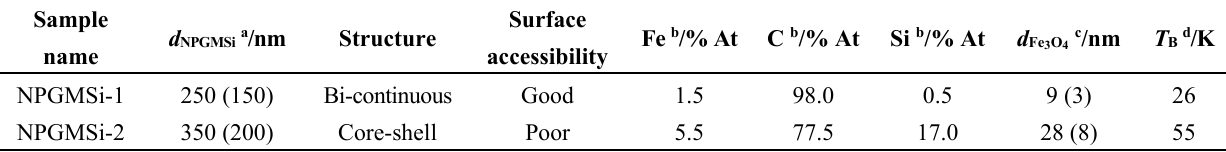
Table 1. The main characteristics of NPGMSi magnetic nanocomposites, including NPGM diameter ( d NPGM ), structure and surface accessibility, Fe, Si and C concentrations, iron oxide colloid diameter ( d Fe ) and blocking temperature ( T B 3 O 4